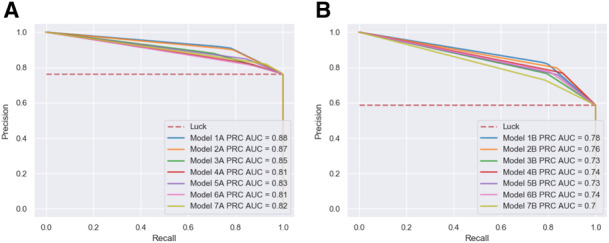
Precision-recall curves for selected models for P1 dataset (A) and P2 dataset (B)